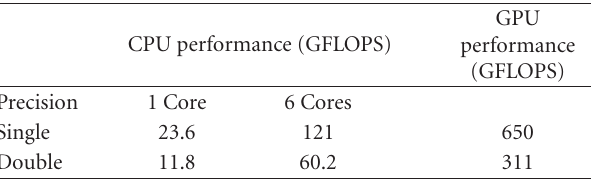
Table 1: Measured peak CPU and GPU performance in GFLOPs for a matrix multiply experiment using Matlab and Jacket. The GPU achieves a factor of ∼ 5 improvement over the multicore